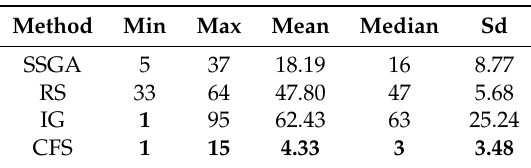
Table 4. Number of features selected.